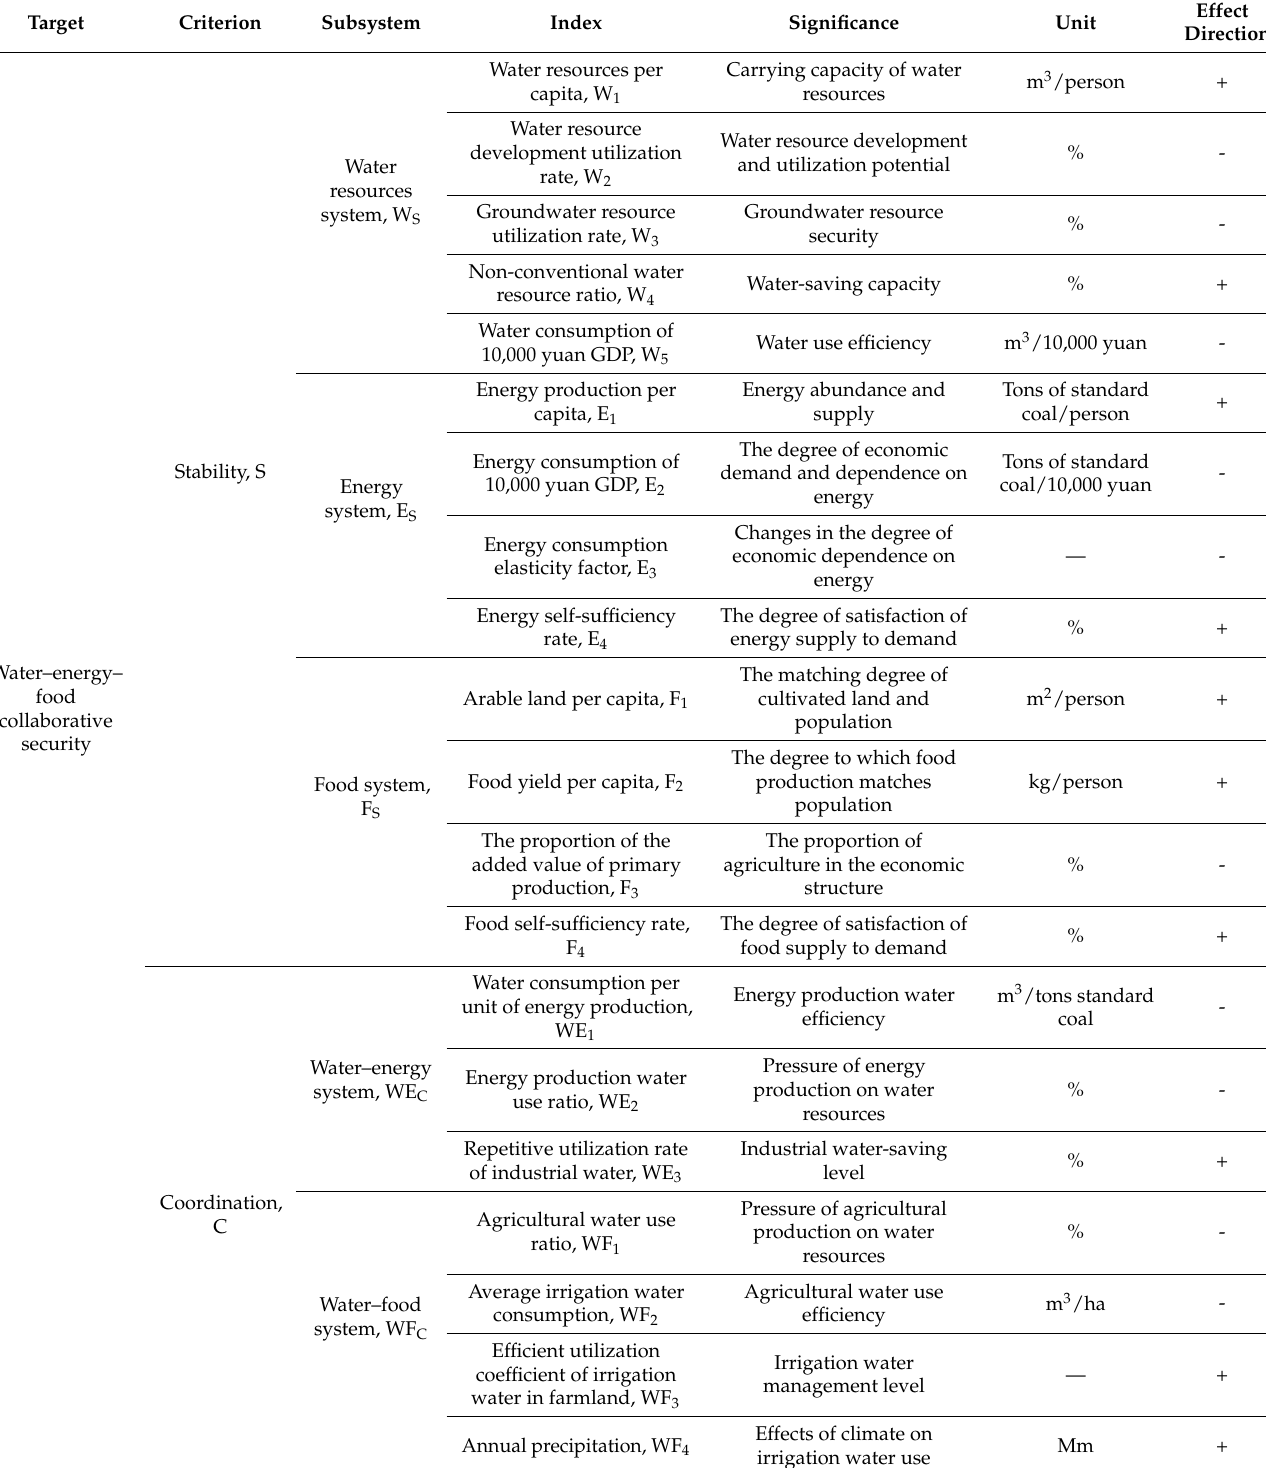
Table 2. Evaluation index system of water–energy–food cooperative